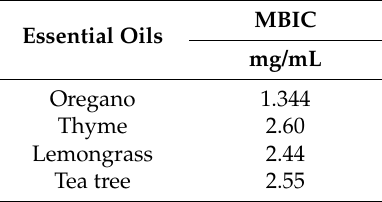
Table 3. Minimum biofilm inhibitory concentration (MBIC) of the selected EOs against S. epidermidis